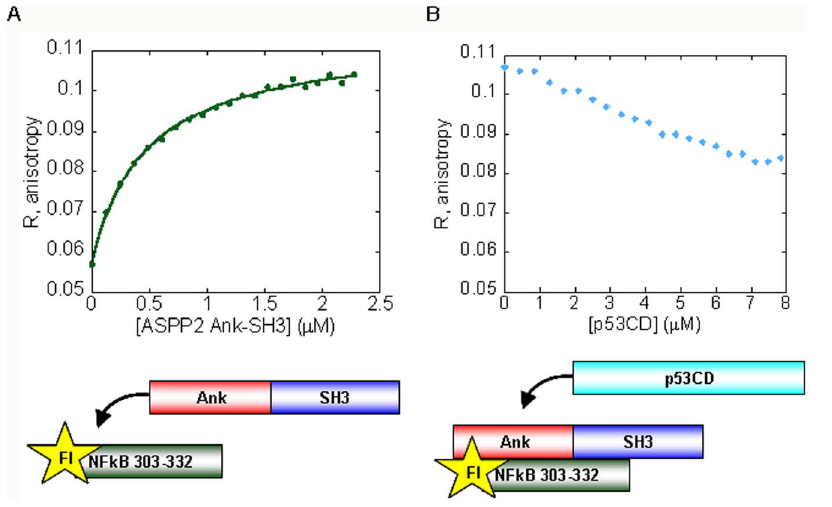
Figure 5. p53CD displaces NF k B 303–332 from its complex ASPP2 Ank-SH3. (A) Binding of ASPP2 Ank-SH3 to Fl-NF k B 303–332 resulting in K